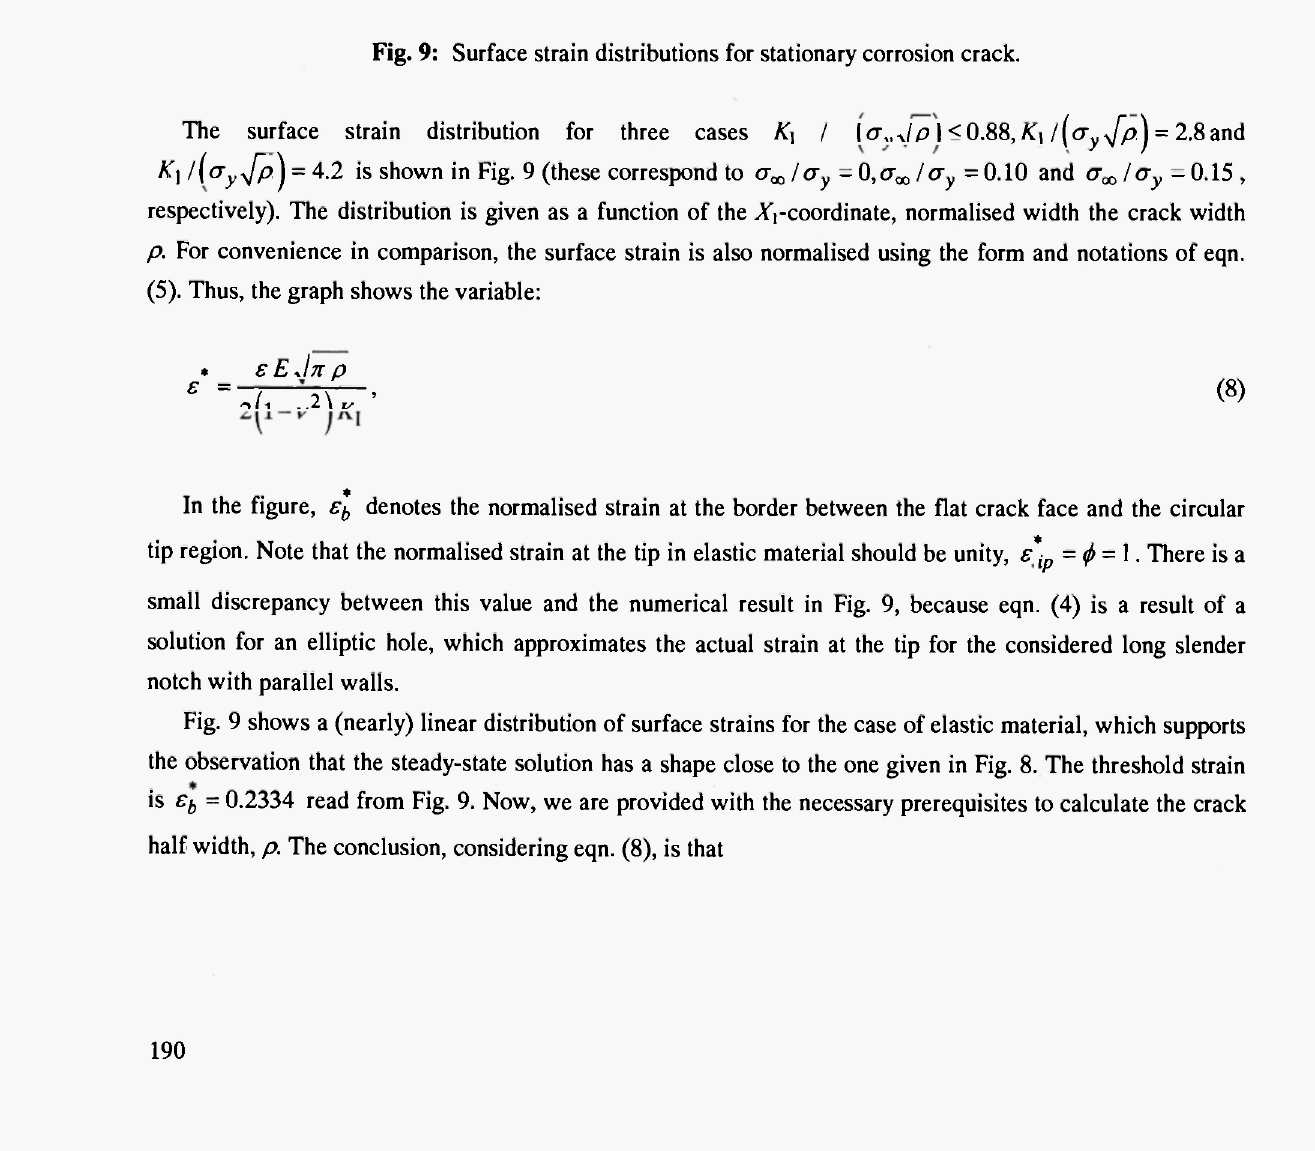
Fig. 9: Surface strain distributions for stationary corrosion